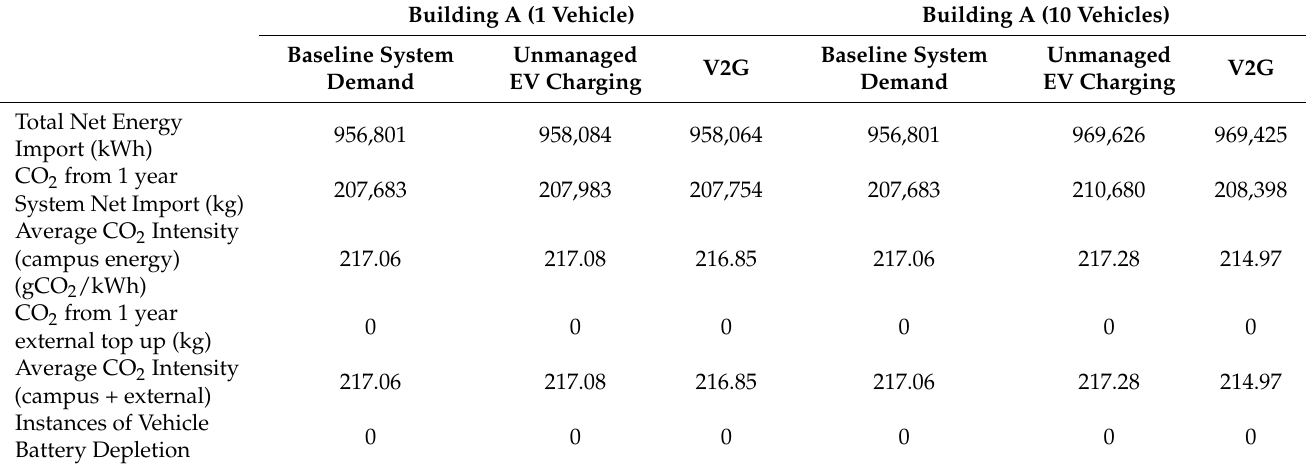
Table 11. Simulated CO 2 emissions of Building A.